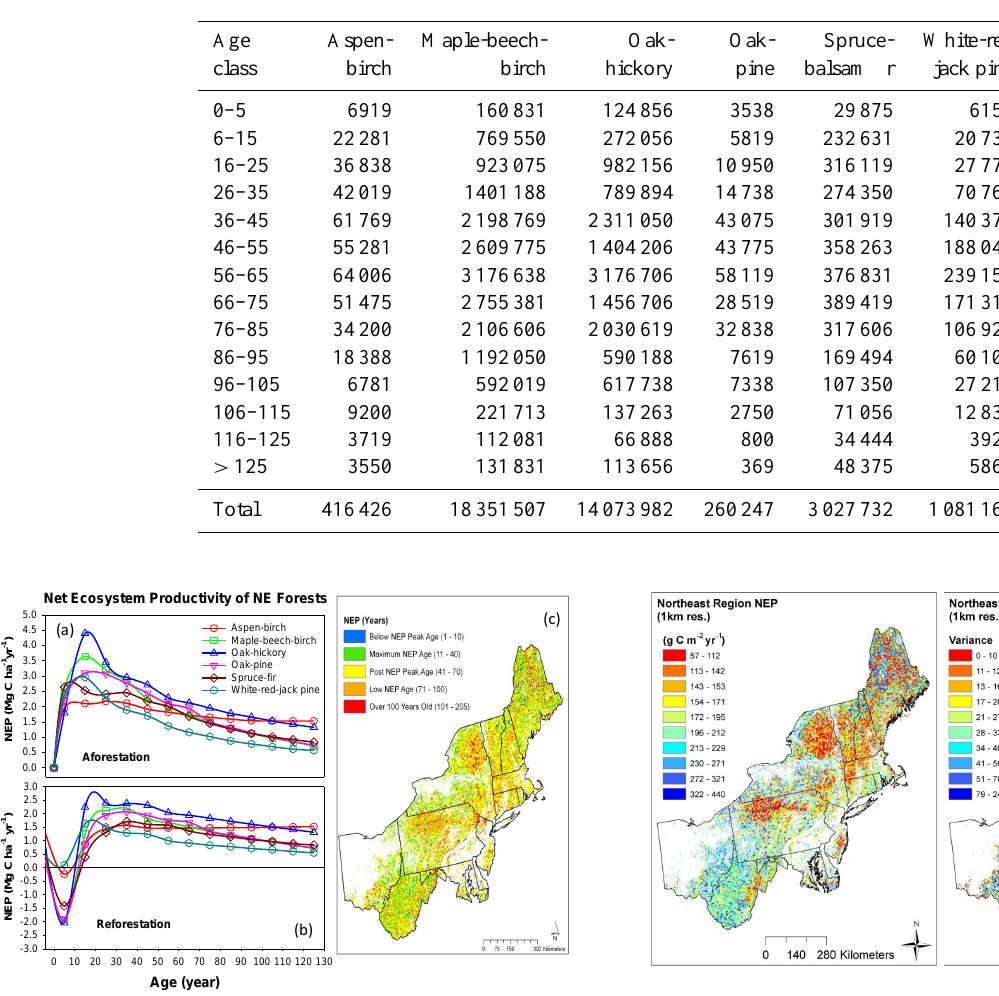
Figure 6. Mean annual net primary productivity of Northeast region forests based on forest inventory data: (a) from afforestation sites; (b) from deforestation sites, NEP loss from woody product is not counted in the initial year, and (c) Northeastern forests with different NEP levels related to age.